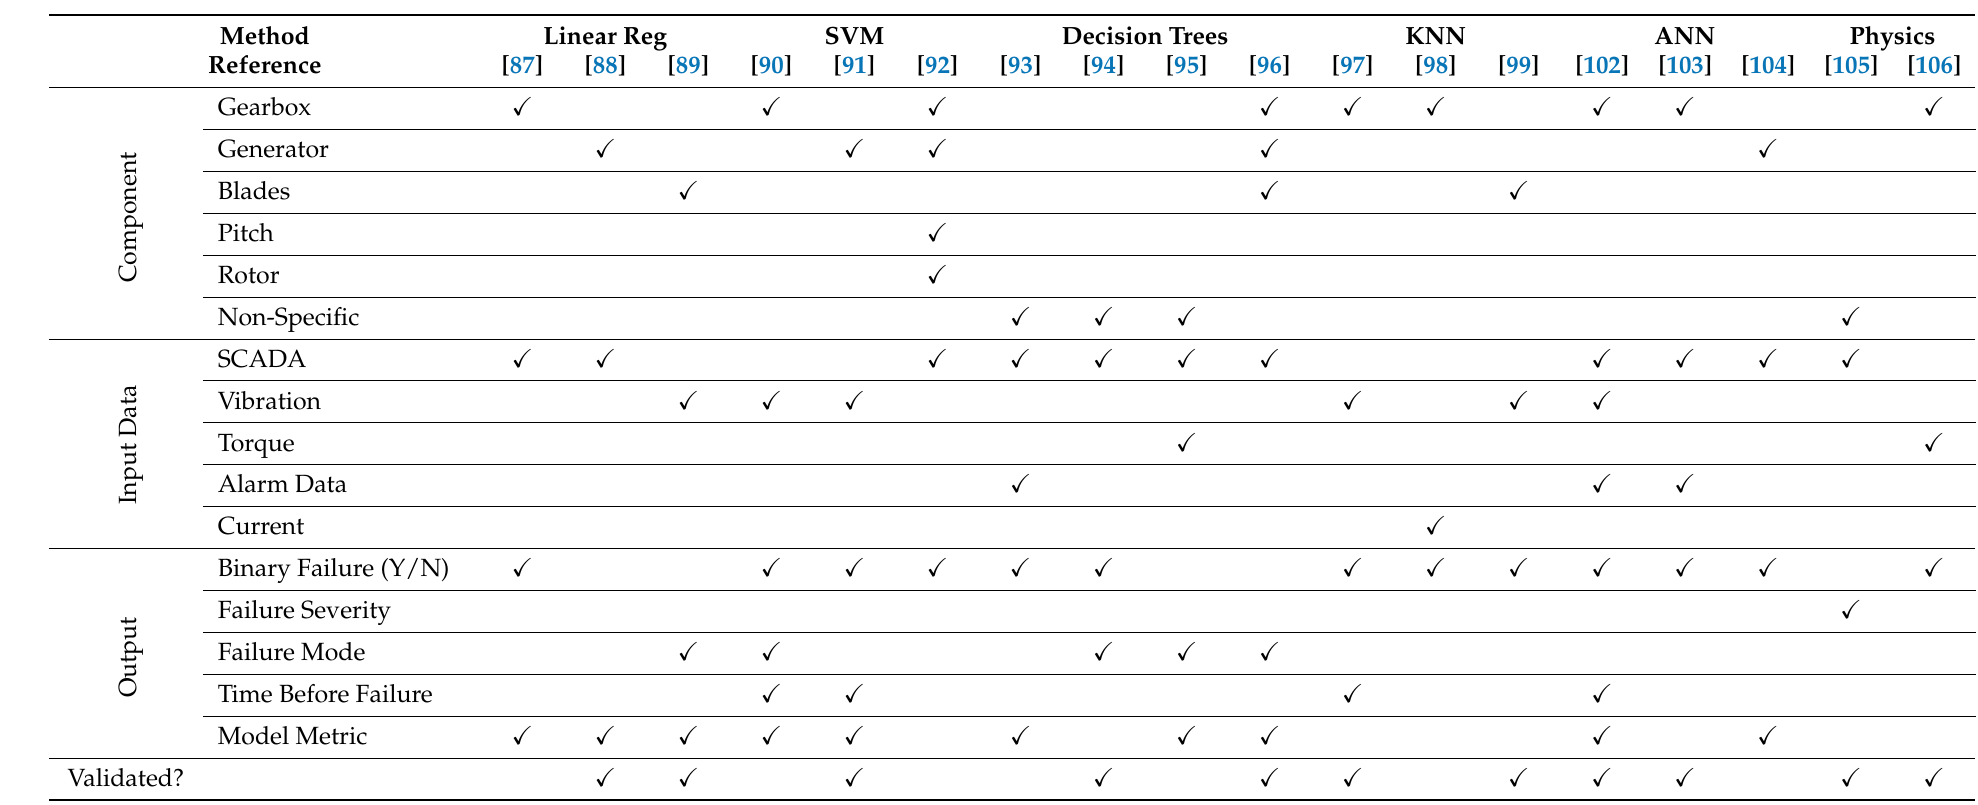
Table 2. Summary of references considered in Section 4.4 regarding failure